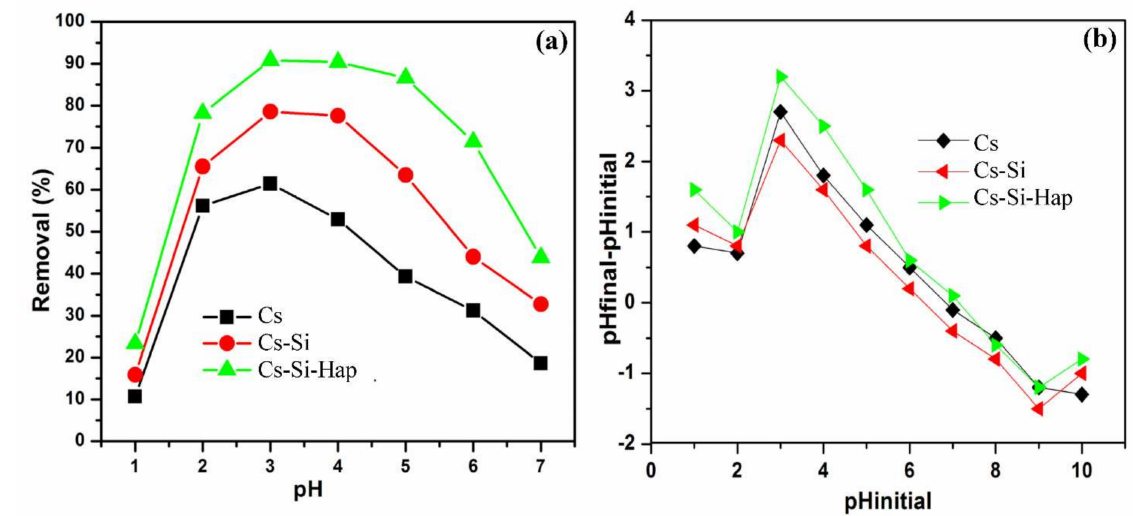
Figure 5. pH studies plots for Cr(VI) adsorption on Cs and Cs based composites ( a ), and point of zero charge (pH PZC ) plots of Cs and Cs based composites ( b